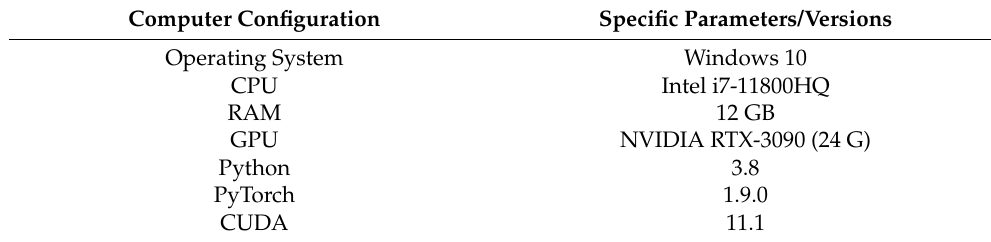
Table 5. Basic configuration of the local computer.